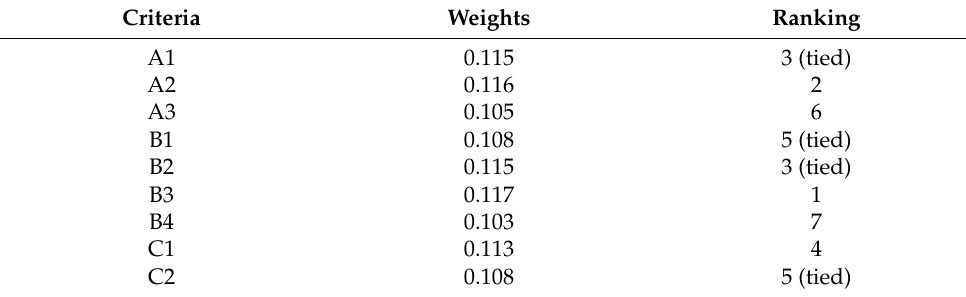
Table 8. DANP Weight Ranking Order of Criteria.